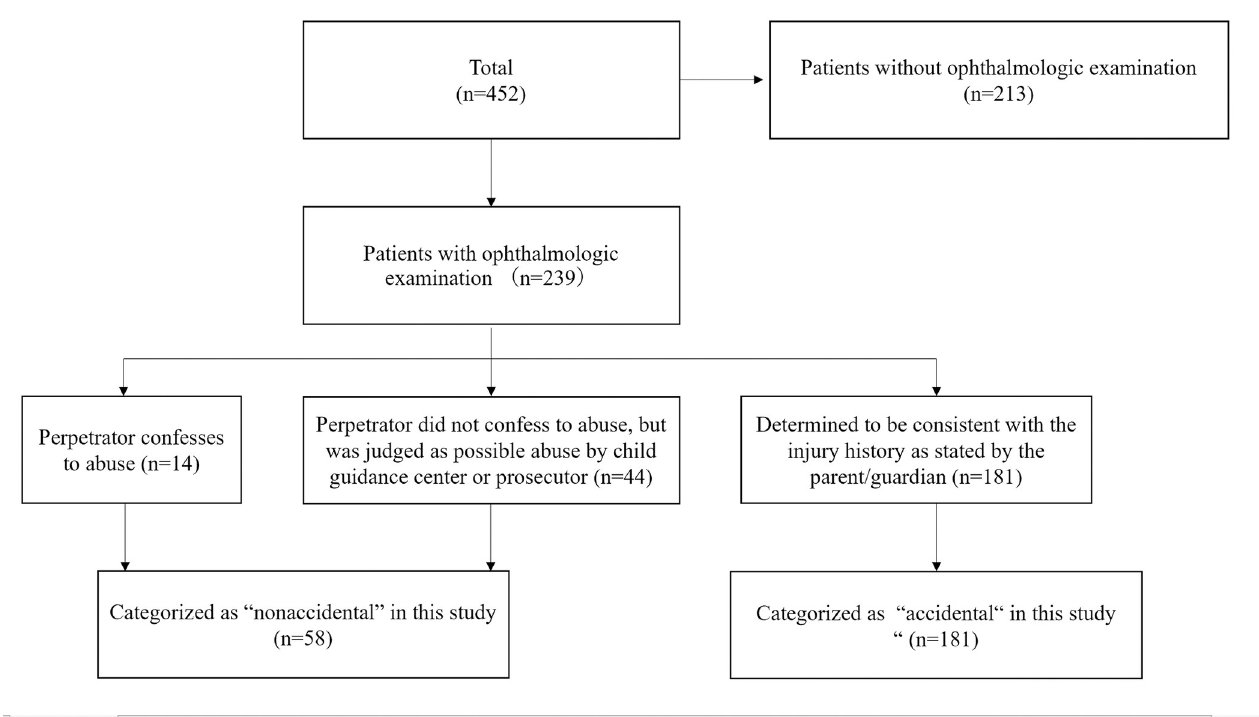
Fig 1. Flow chart of patient selection. Of the 452 registered cases, 294 without ophthalmological examinations were excluded. Of the remaining 239 cases, 58 were categorized as “nonaccidental” and 181 as “accidental”.